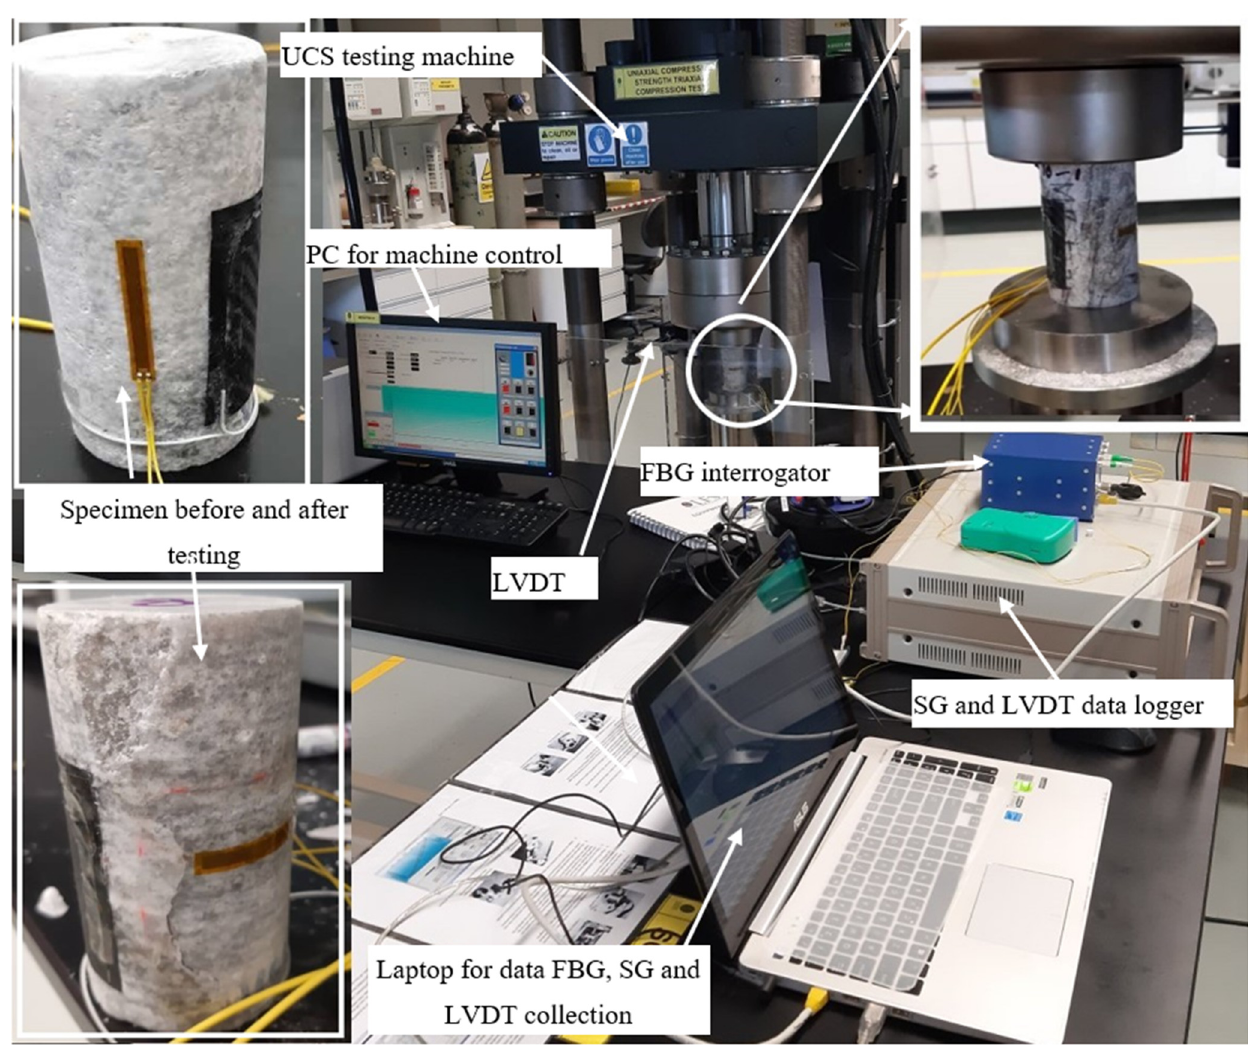
Figure 5. Experimental setup.